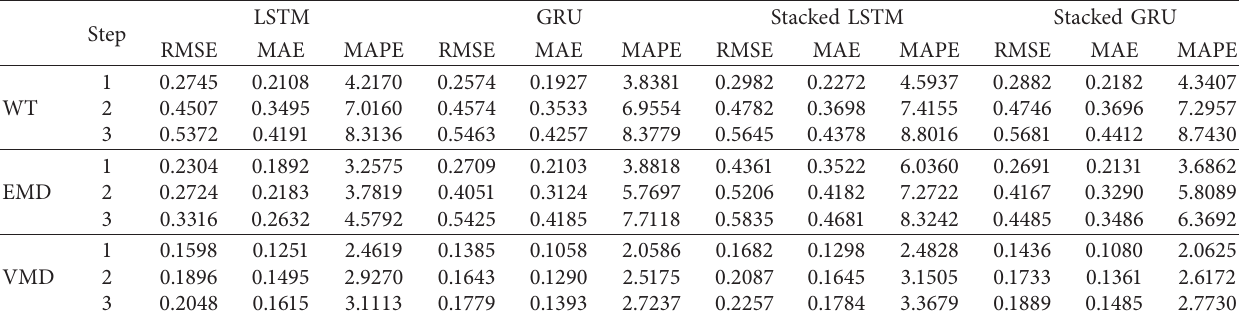
Figure 7: Visualization of datasets used in experiments. (a) Original time series. (b–d) Trends and seasonality in areas 1–3. Table 3: Result of different combination of decomposition and prediction